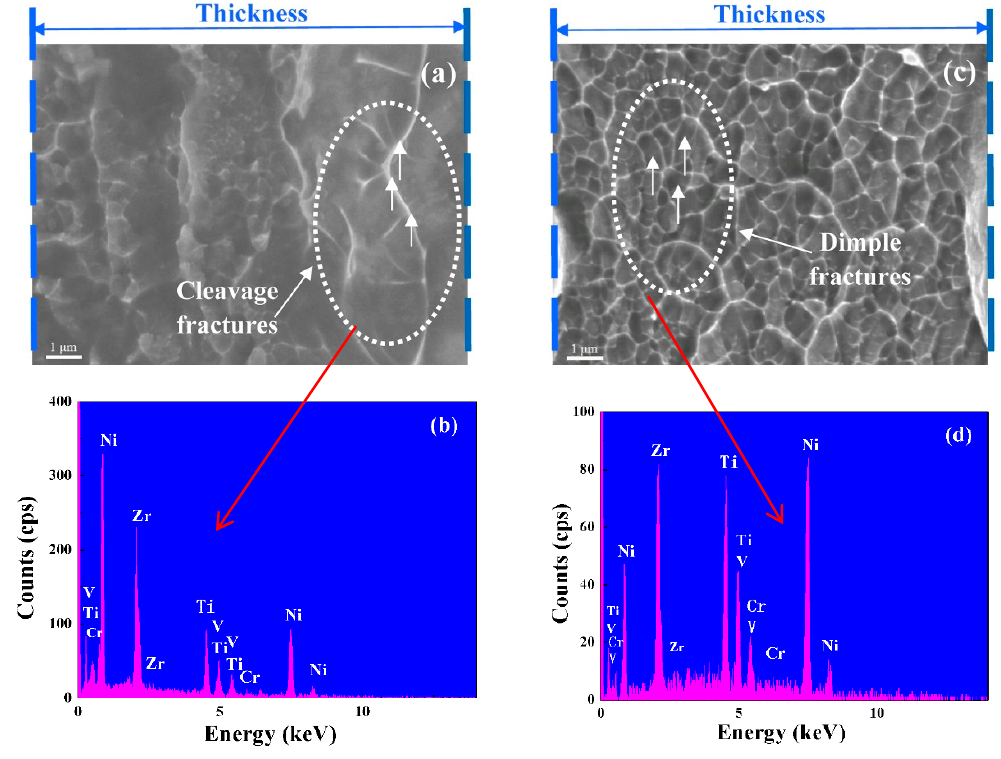
Figure 5. Fracture SEM images and EDS analysis of (TiZr) 0.5 (Ni 0.6 Cr 0.1 V 0.1 ) 2.1 ribbons with spinning speeds of 30 m/s and 45 m/s; ( a ) 30 m/s microfracture; ( b ) 30 m/s EDS; ( c ) 45 m/s microfracture; ( d ) 45 m/s EDS.